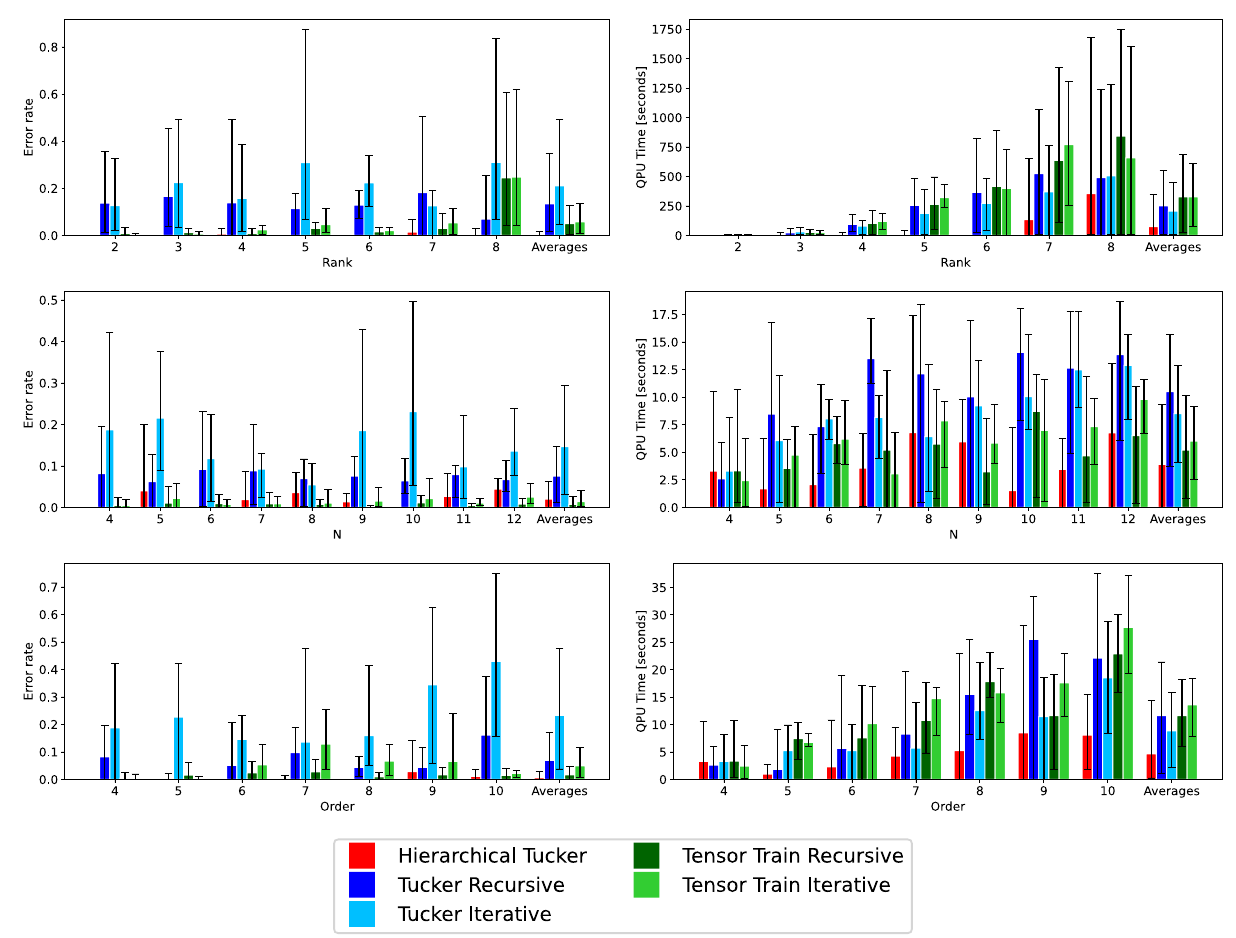
Figure 7. Tensors with no noise. Mean error rate (left column) and mean QPU time (right column). Tensor rank (top row), dimension size N (middle row), and tensor order (bottom row). The right most entry on the x-axis shows the average across all previous quantities for each of the five tensor methods. Error bars indicate minimum and maximum